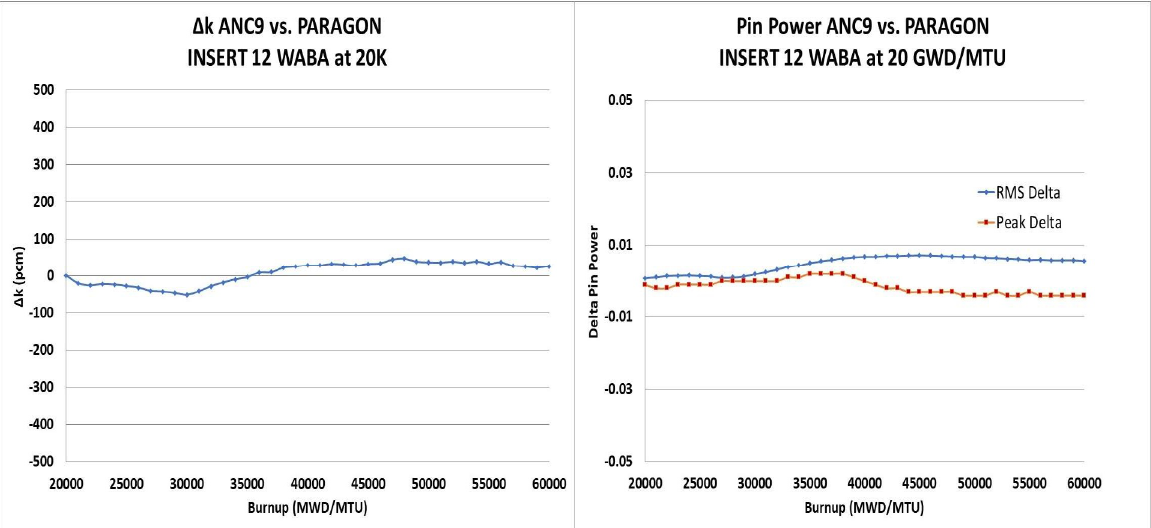
Figure 4. Comparison of eigenvalue and pin power for 12 WABA rods inserted at 20